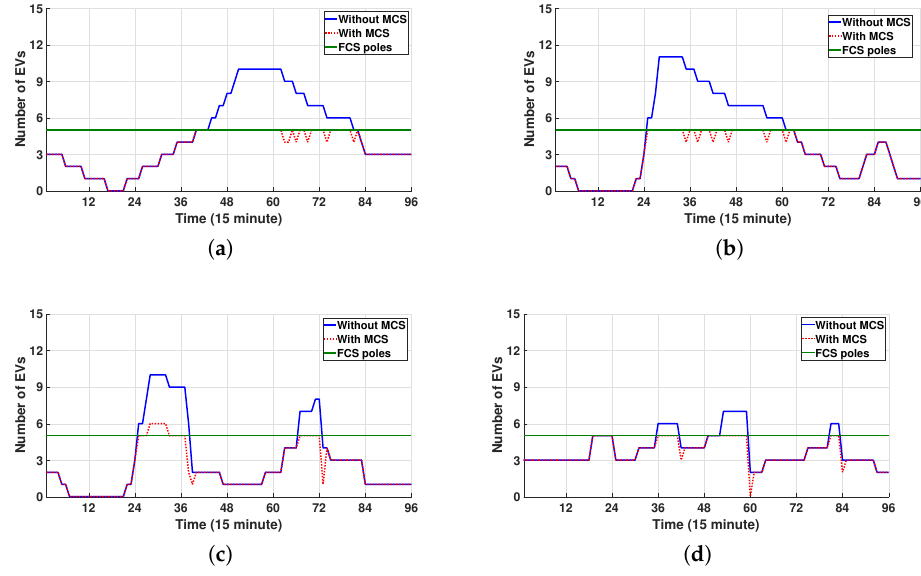
Figure 13. Comparison of the number of EVs without and with MCS between four FCSs. ( a ) FCS1.